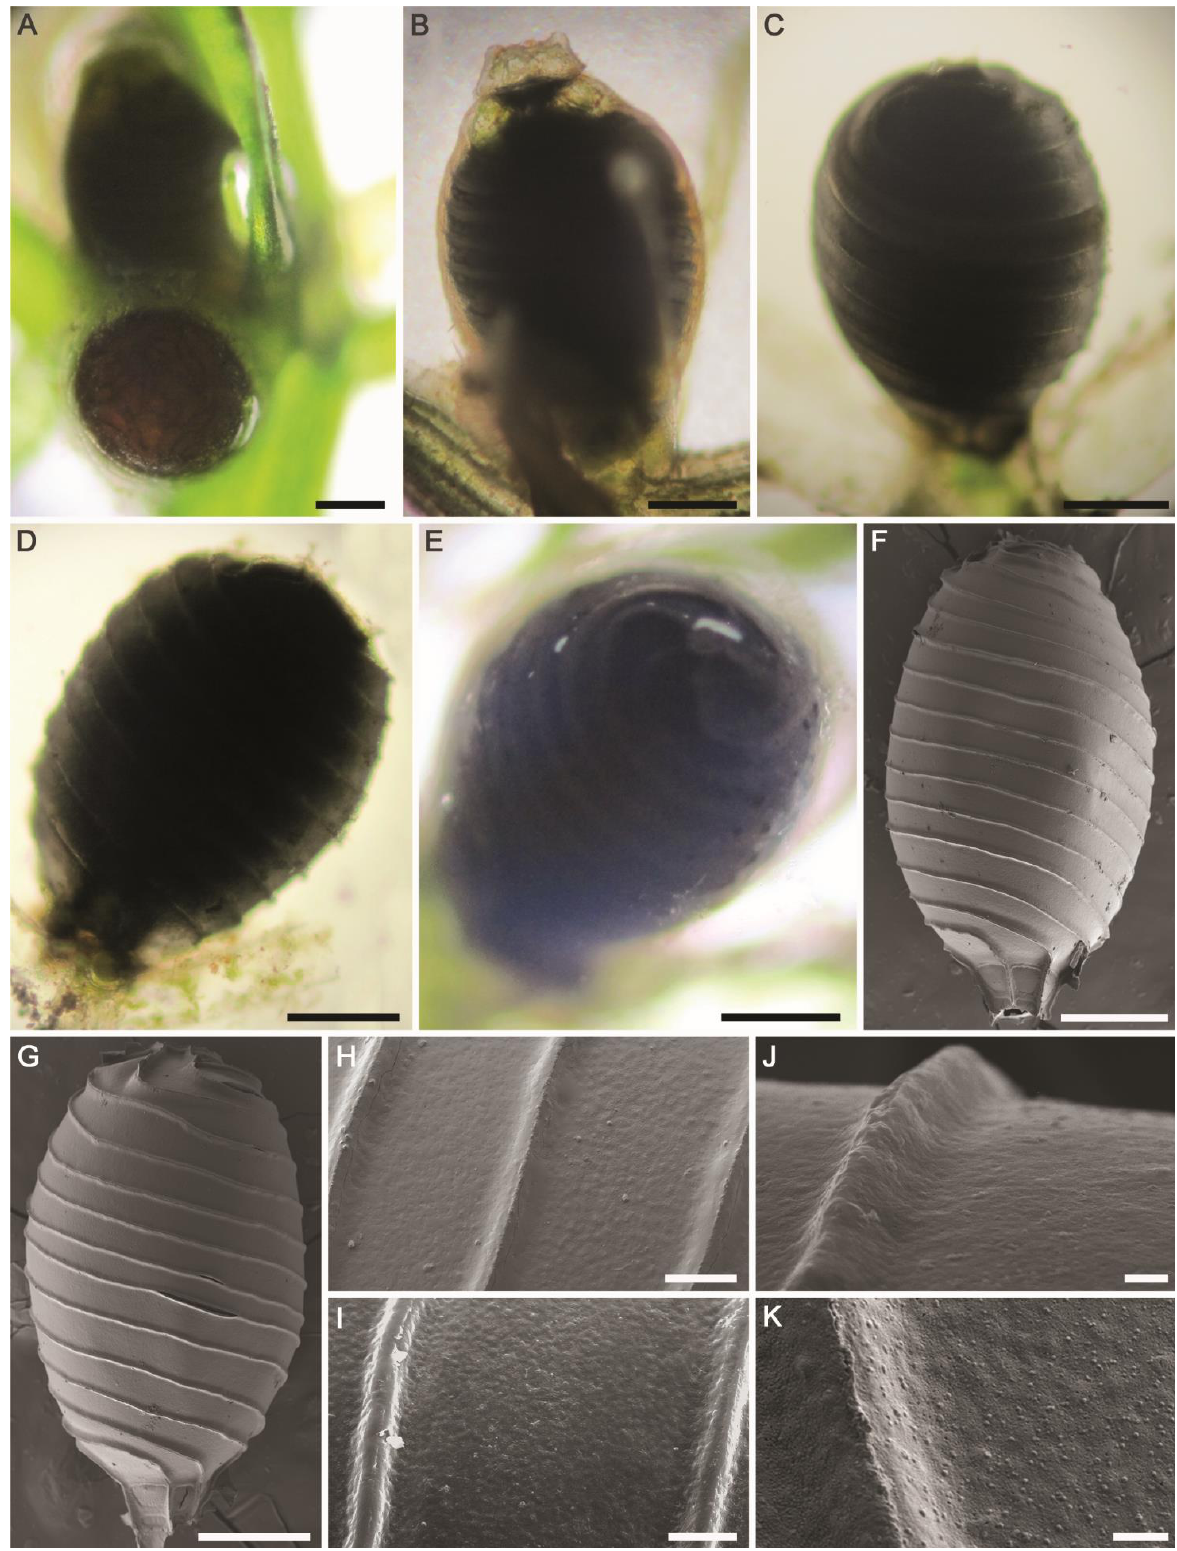
Figure 9. Morphotaxonomic features of Chara globata found in the thermal mineral desert spring ‘Ain Wazedi’ in the Siwa Oasis (the Western Desert of Egypt): ( A ) branchlet node with conjoined gametangia.; ( B ) fertilized oogonium; ( C – E ) mature oospores; ( F – K ) SEM of the oospores. Note smooth and pustular (to weakly papillate) ornamentation covering fossa and ridges. Scale bars: ( A – G ) = 200 μm; ( H , I ) = 20 μm; ( J , K ) = 5 μm.